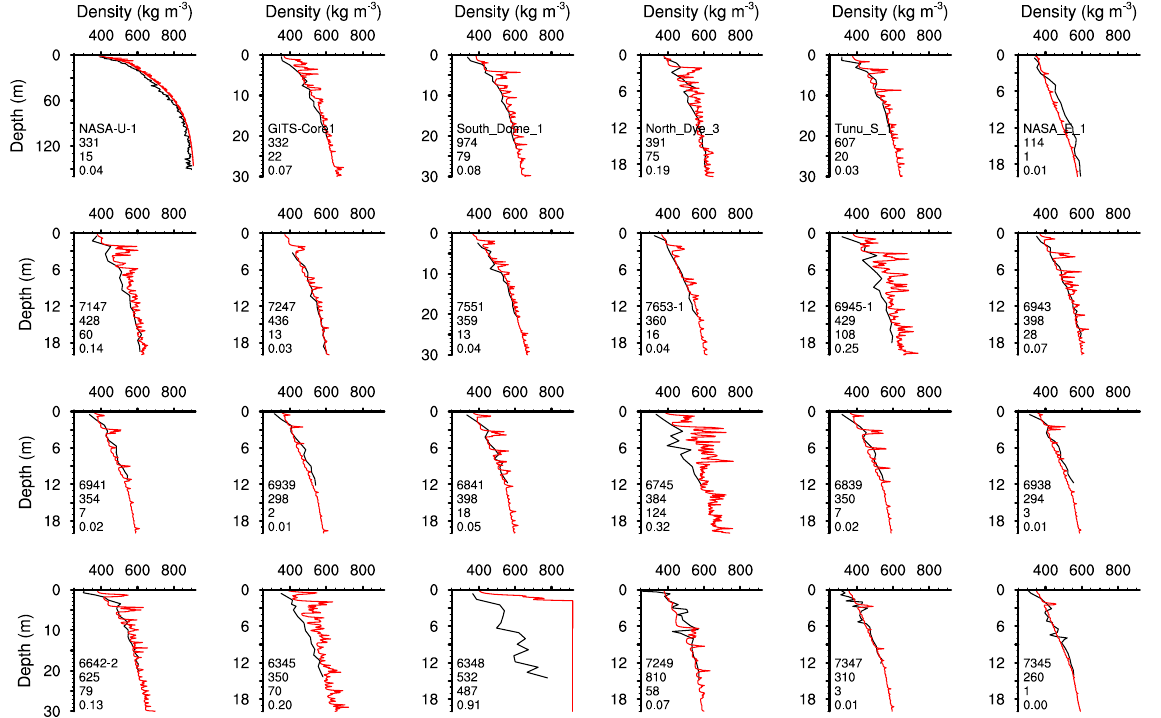
Figure A1. Observed (black) and modelled (red) firn density profiles for 24 of the 62 firn cores on the Greenland Ice Sheet. The four lines of text in each panel show (1) the core name, (2) mean annual accumulation and (3) melt (in mmw.e.yr − 1 ) from RACMO2.3, and (4) the ratio of these fluxes ( R ma , dimensionless). The other vertical profiles are shown in Figs. 3 and A2.